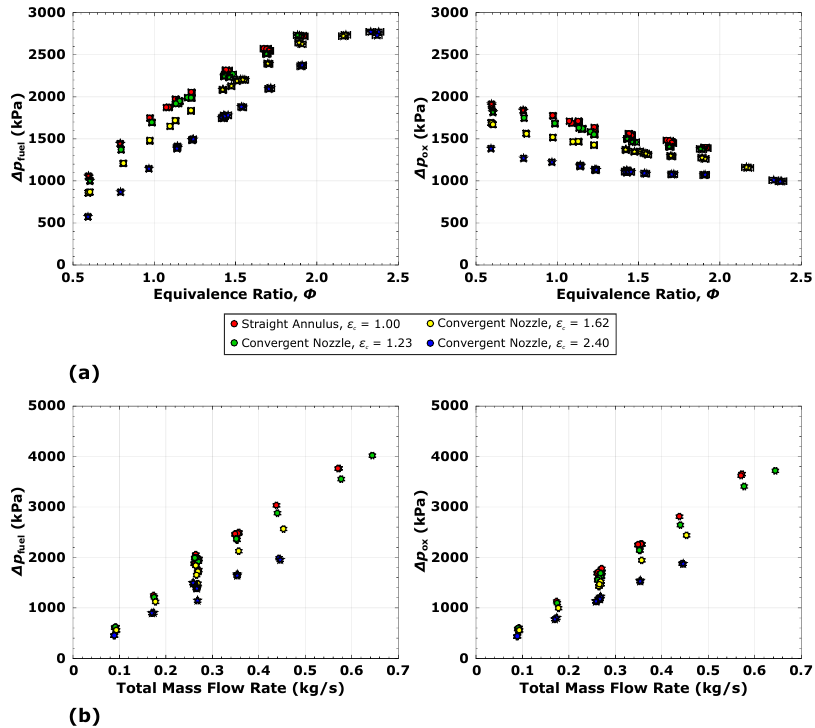
Figure 7. Injector pressure drop of the fuel ( left ) and oxidizer ( right ) for the ( a ) equivalence ratio (at ˙ m tot = 0.272 kg/s) and ( b ) mass flow rate conditions (at φ = 1.15), respectively. Depending on the flow condition and convergent nozzle geometry, the engine operates in either a corotating ( • ) or counter-propagating mode ( (cid:63) ).